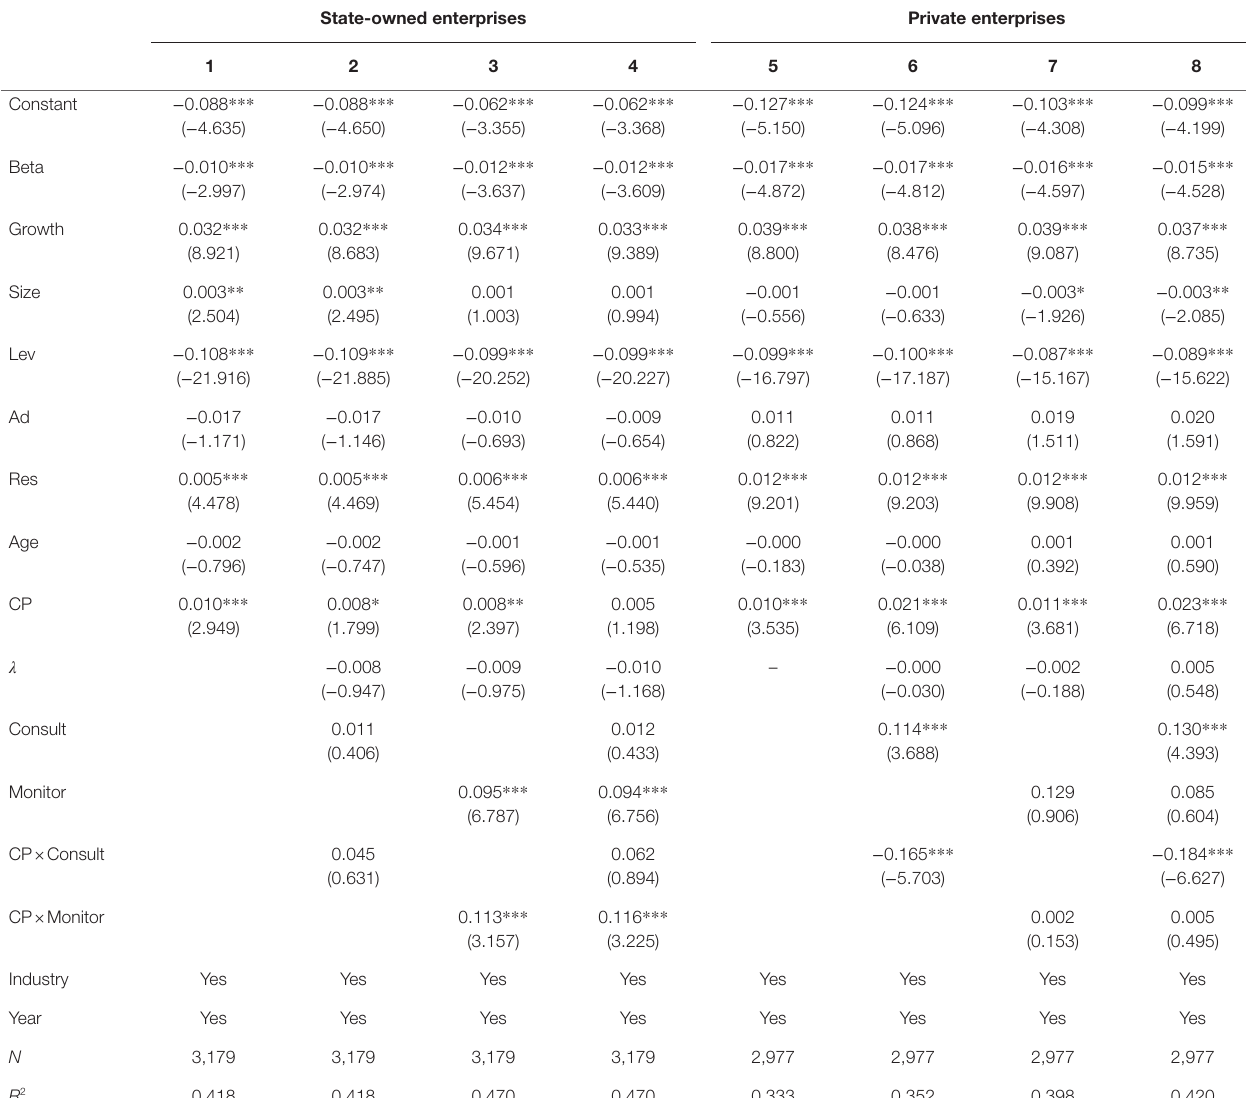
TABLE 4 | Regression results of the functions of the BOD in CP. (Heckman